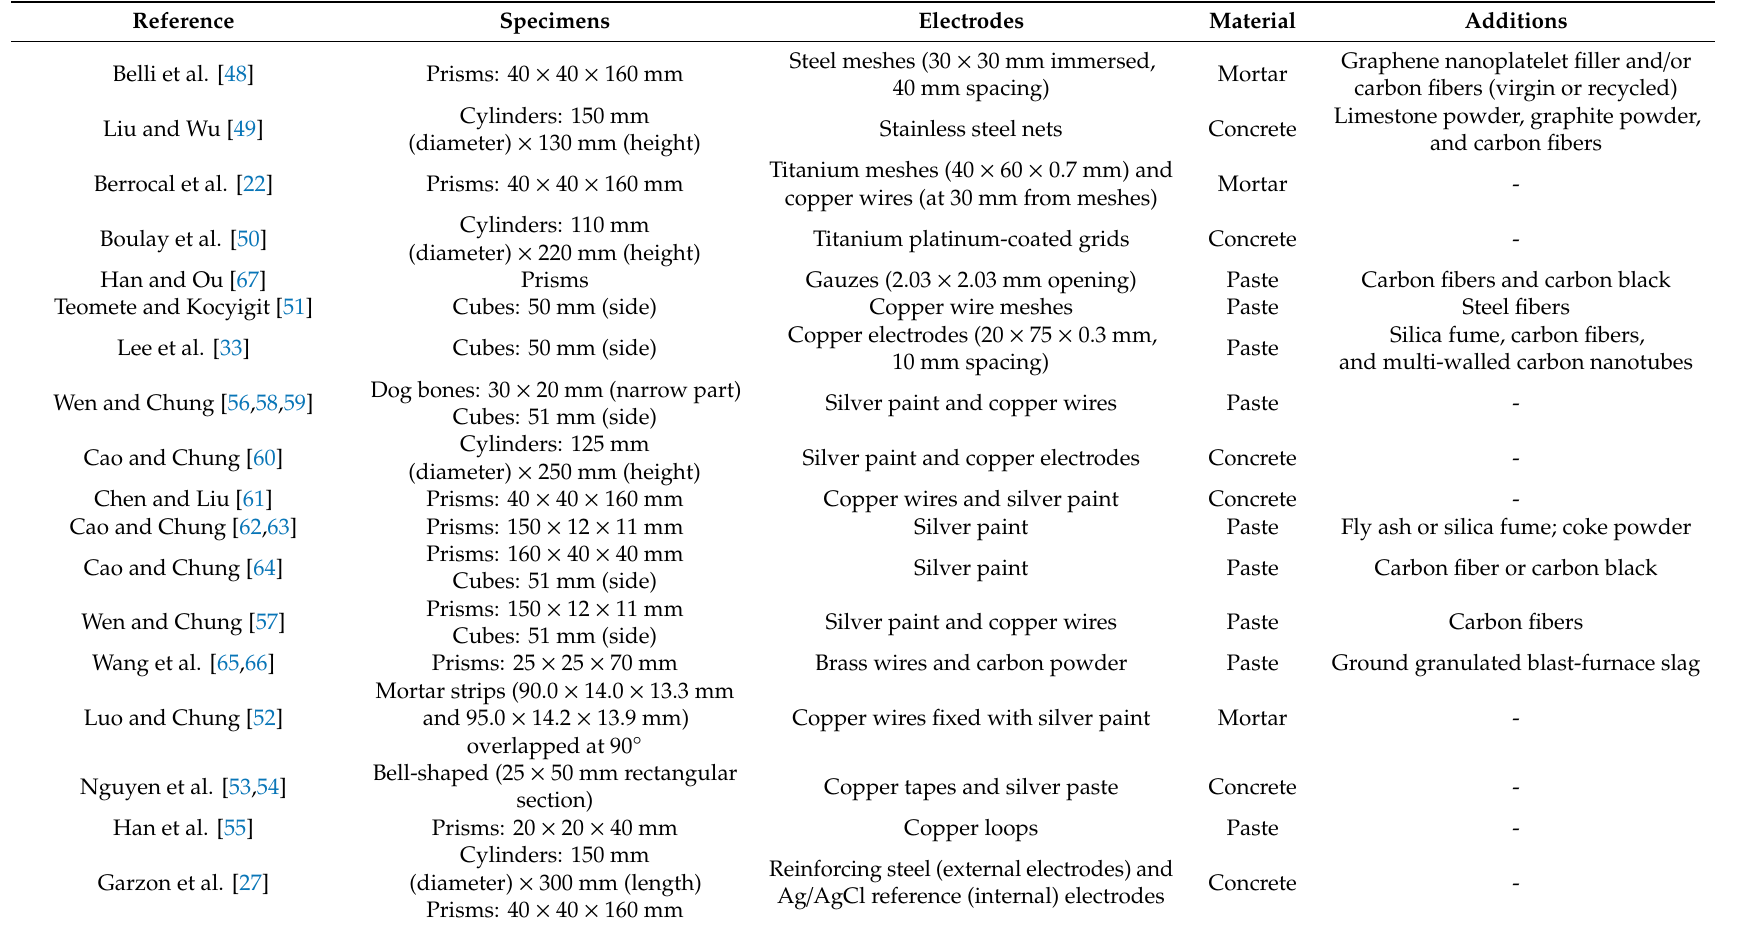
Table 2. DC measurements with 4-point probe